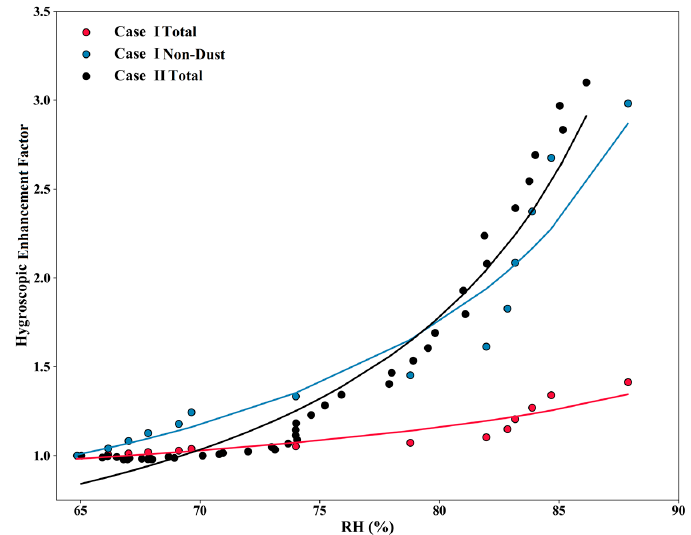
Figure 7. The red (Case I) and black (Case II) dots and lines correspond to Figure 5. The blue dots represent the non-dust fine-mode hygroscopic growth factors retrieved on 5 February 2019 (Case I) from 1050 to 1150 UTC within the 410–540 m layer (RH ref =